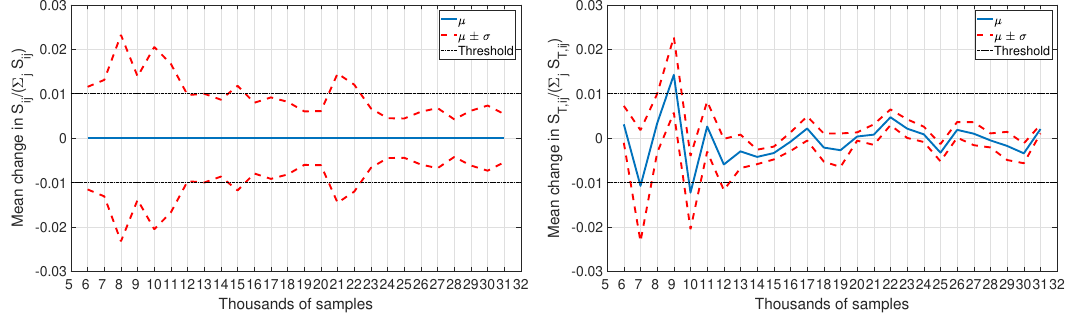
( a ) Mean change in S ij with the increase in the number of samples. Figure 4. Stability of the sensitivity indices calculated by Saltelli’s approximation. The mean change is